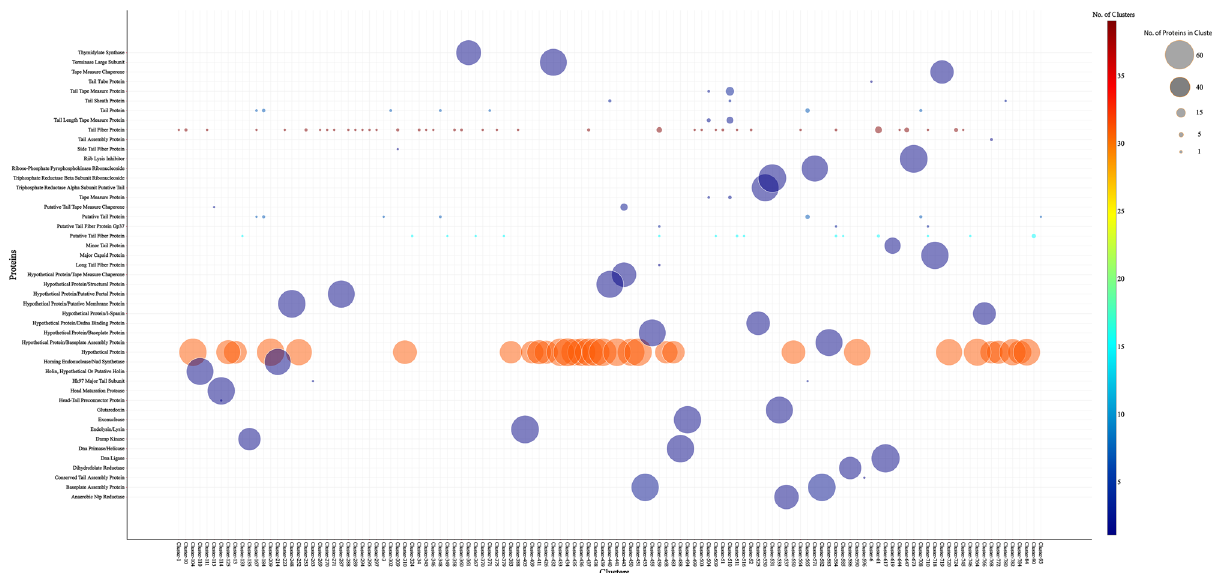
Figure 6. Bubble plot of crucial protein clusters. Crucial proteins clusters distilled by clustering of Phage proteome are represented as bubbles. Color of bubble represents the number of clusters that contain the protein kind, ranging from dark brown to dark blue. And the size of the bubble represents the quantity of the protein kind within the